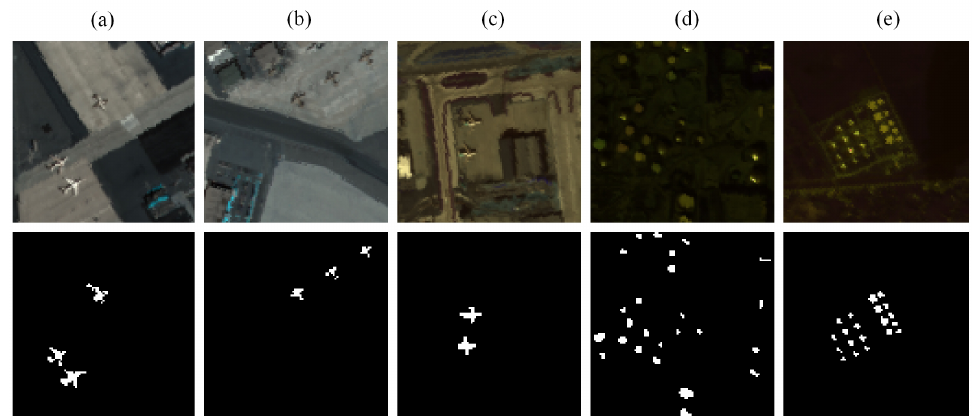
Figure 3. Pseudocolor images and the corresponding ground truth of the five HSI